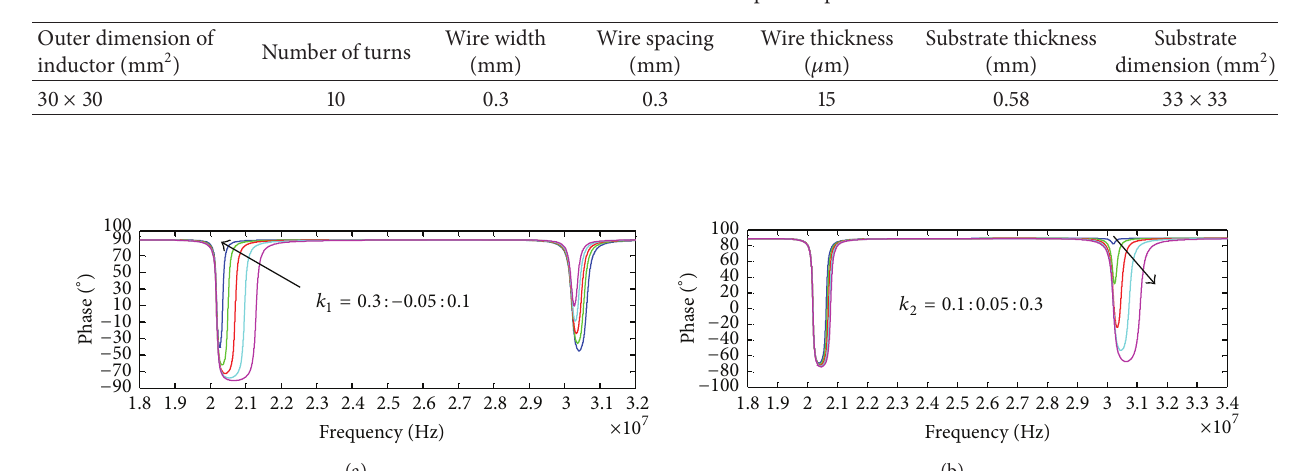
Table 7: Dimensions of the PCB-based planar spiral coil.